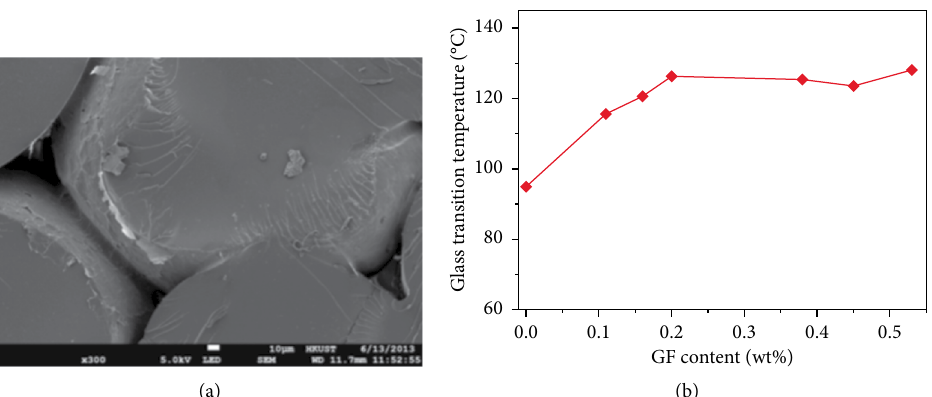
Figure 3: (a) SEM image of 3D graphene (0.2 wt%)/epoxy composite. (b) Glass transition temperature reaches its threshold at the loading of 0.2 wt% 3D graphene. Adapted from [93].